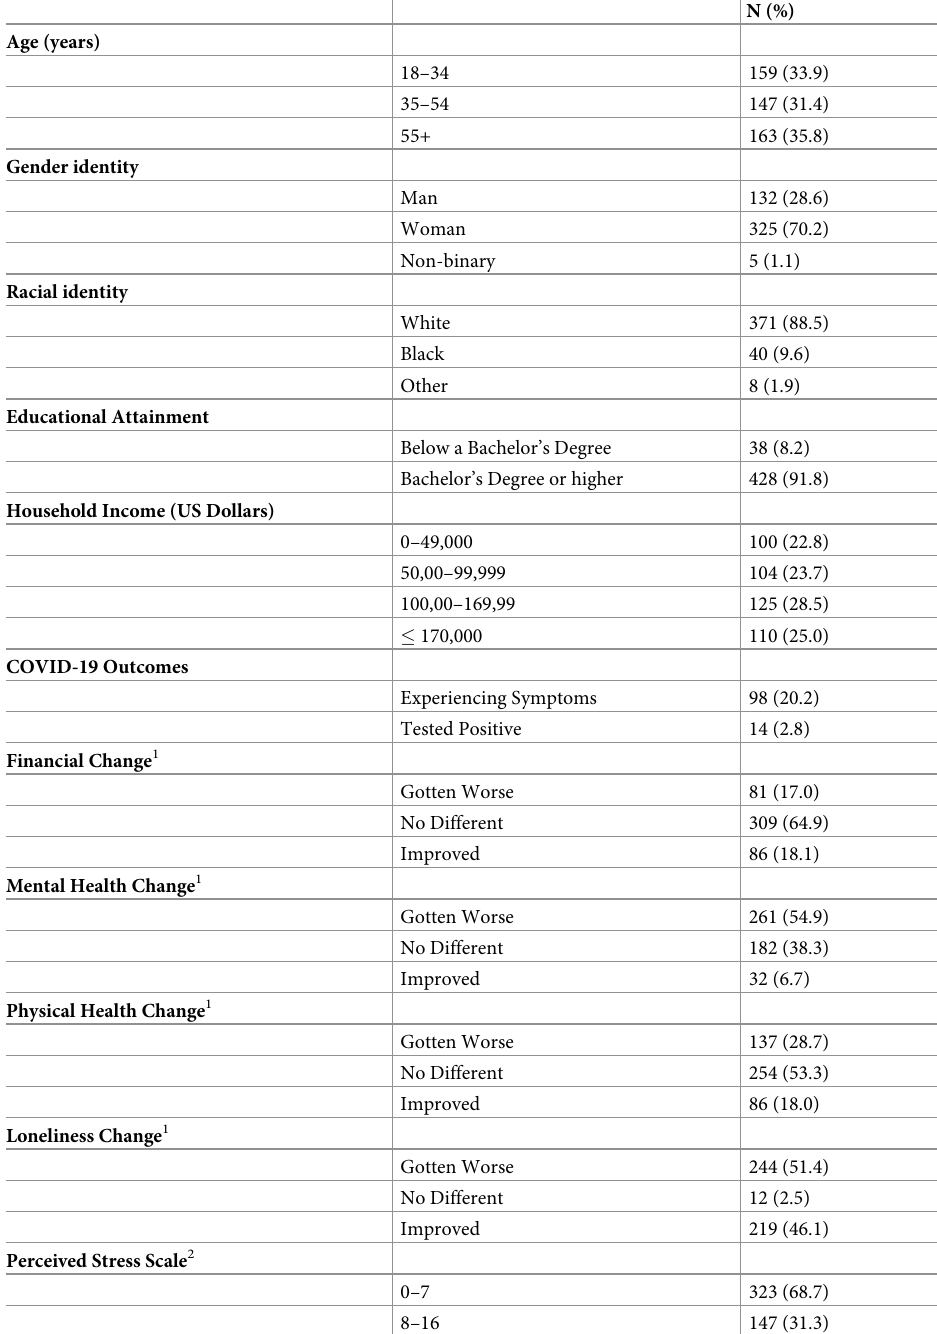
Table 2. Sociodemographic characteristics and health outcomes among survey